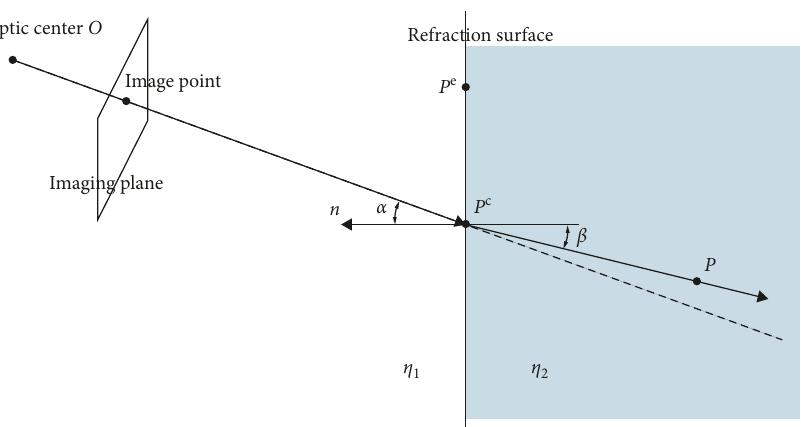
Figure 8: The refraction geometric camera model.